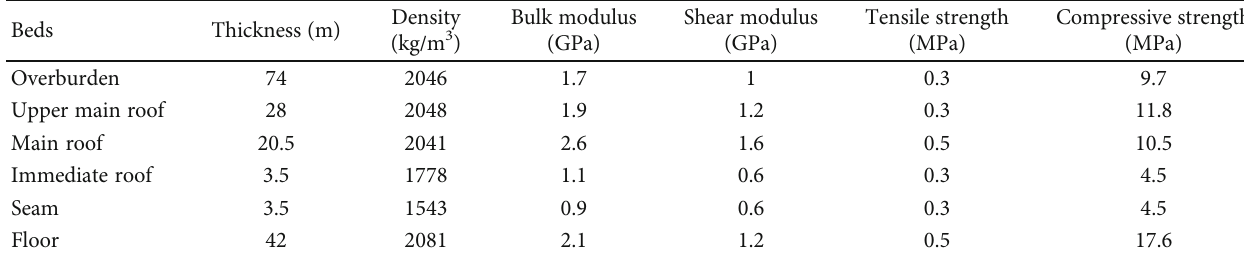
Figure 6: Model geometry. Table 1: Rock mass properties taken as input for numerical